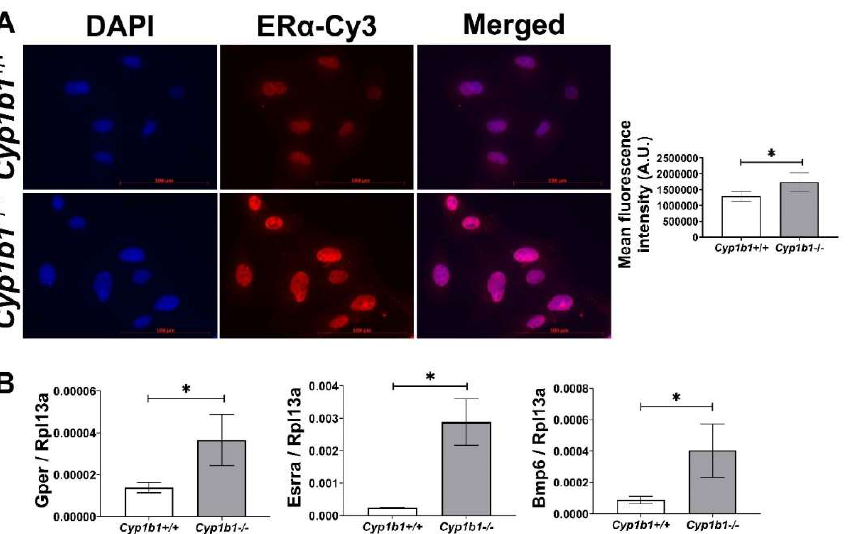
Figure 1. Cytochrome P450 1B1-deficient ( Cyp1b1 − / − ) retinal ECs exhibit increased ER α nuclear localization and ER α -mediated gene expression. ( A ) The nuclear localization of ER α was determined by indirect immunofluorescence staining. Images were captured in digital format (left panel, scale bars = 100 µ m). Integrated fluorescence intensities of images were measured and normalized by cell number for quantitative analysis (right panel). Cyp1b1 − / − retinal ECs showed significantly increased nuclear localization of ER α (* p < 0.05; n = 5). ( B ) qPCR analysis confirmed enhanced expression of ER α -downstream target genes, including G-protein-coupled ER (Gper), estrogen-related receptor alpha (Esrra), and bone morphogenetic protein 6 (Bmp6) (* p < 0.05; n = 3).